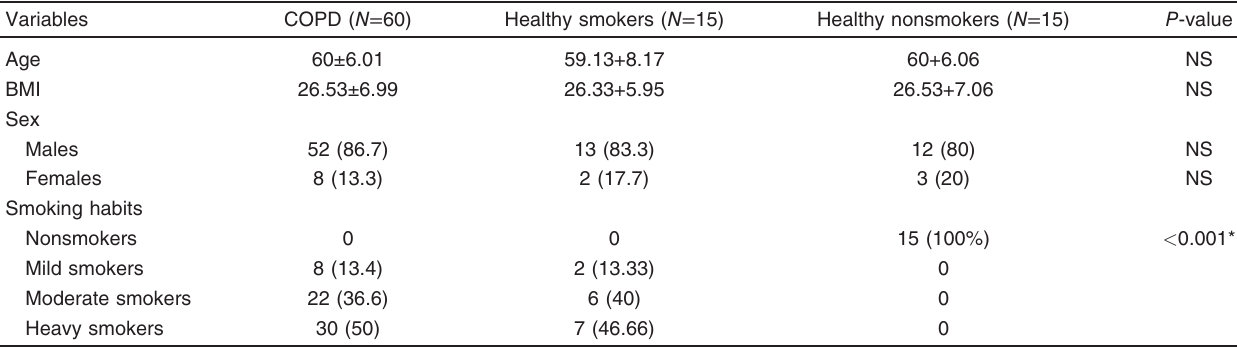
Table 1 Demographic data of the study groups Variables